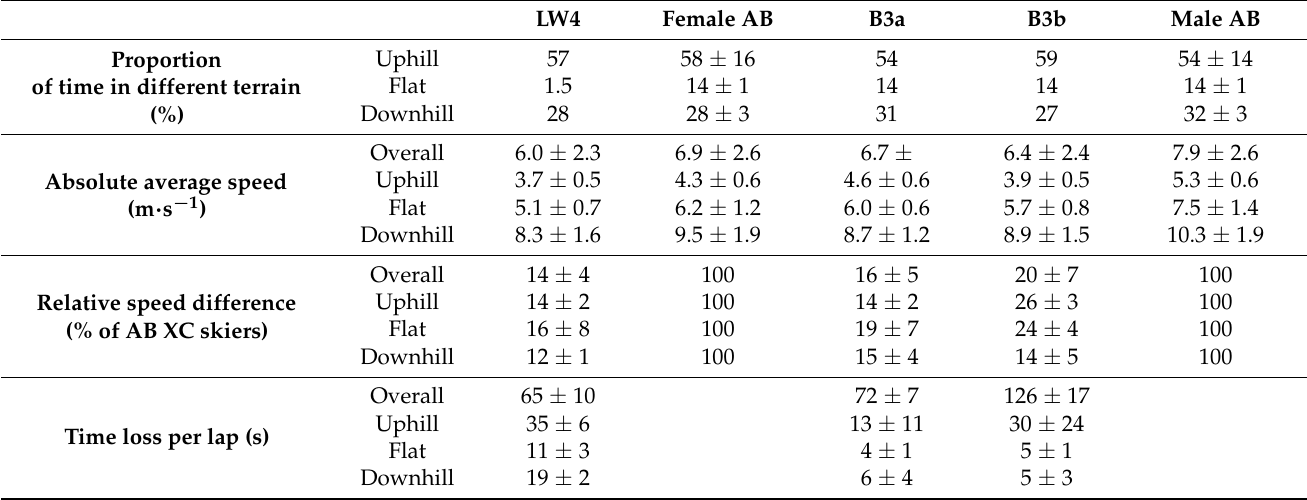
Table 2. Proportion of skiing time in different terrain (%), absolute average speed (m · s − 1 ), relative speed difference (% of AB XC skiers), and time loss relative to AB XC skiers of same sex per lap (s) for the Para and AB XC skiers. LW4 Female AB B3a B3b Male